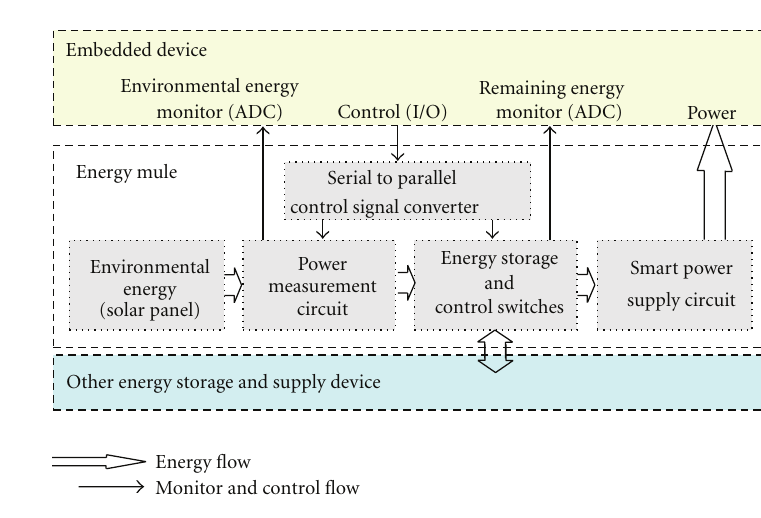
Figure 4: Energy mule hardware